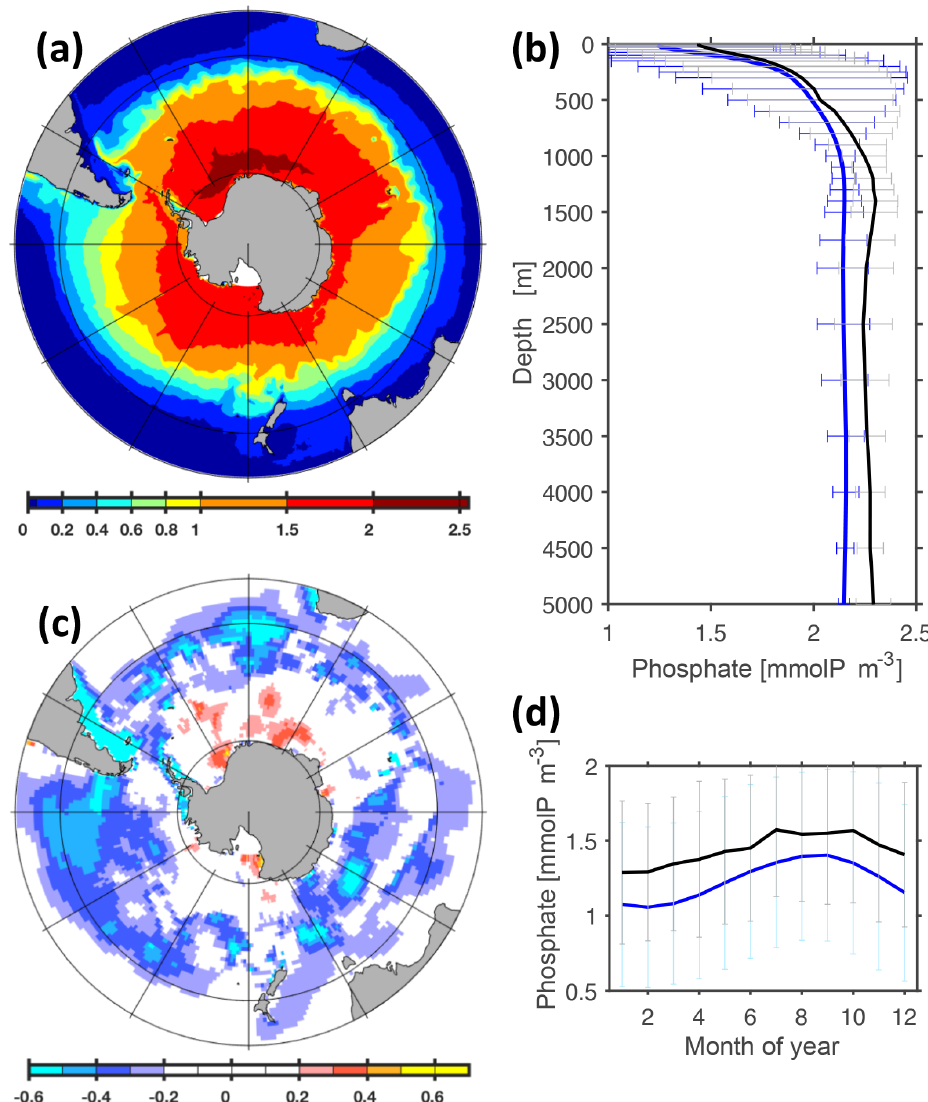
Figure 24. Comparison of simulated and observed phosphate concentrations. Panel (a) refers to simulated surface phosphate concentrations (reference simulation, averaged over nominal years 1993 to 1998). The color bar denotes phosphate concentrations in units of mmolPm − 3 . Panel (b) shows simulated (blue line) and observed (black line) phosphate concentrations averaged horizontally in the Southern Ocean (i.e., south of 40 ◦ S), along with their respective spatial standard deviations (grey and blue horizontal bars). Panel (c) shows the difference between simulated and observed (Garcia et al., 2010) surface concentrations. Panel (d) shows the simulated (blue line) and observed (black line) seasonal cycle of dissolved phosphate concentration at the surface calculated as monthly means averaged over the Southern